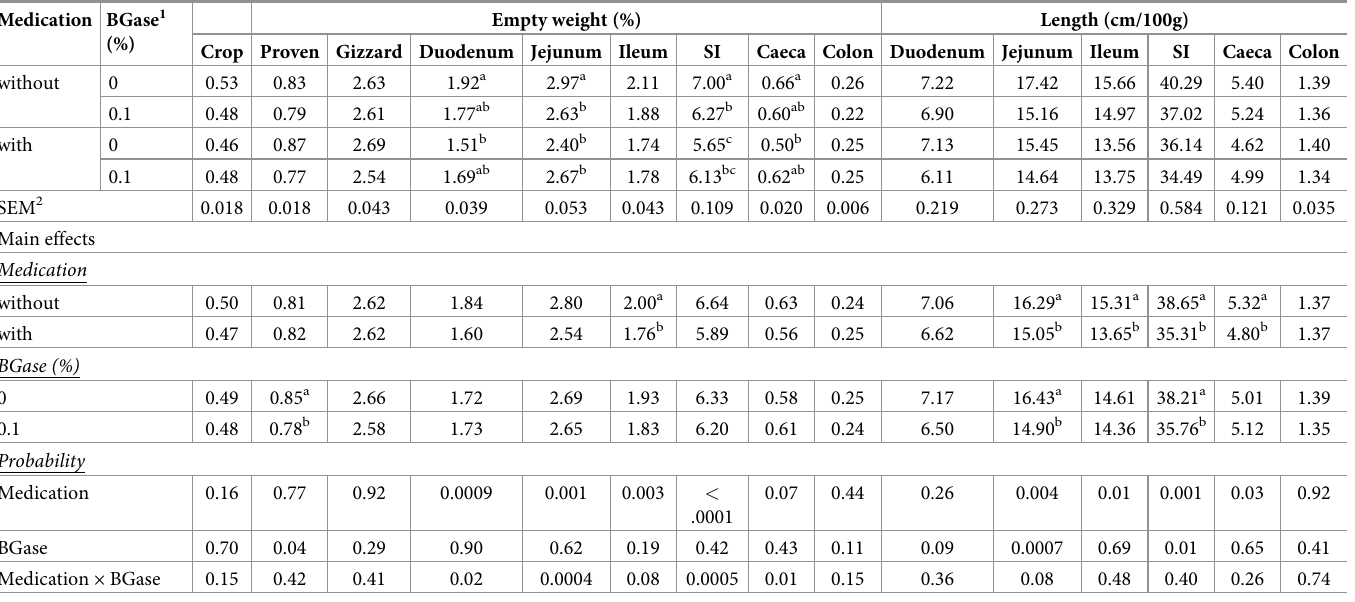
Table 16. Effects of diet medication and β -glucanase on gastro-intestinal tissue weights and lengths (proportional to body weight) of broiler chickens at day 11 (Experiment 2). Medication BGase 1